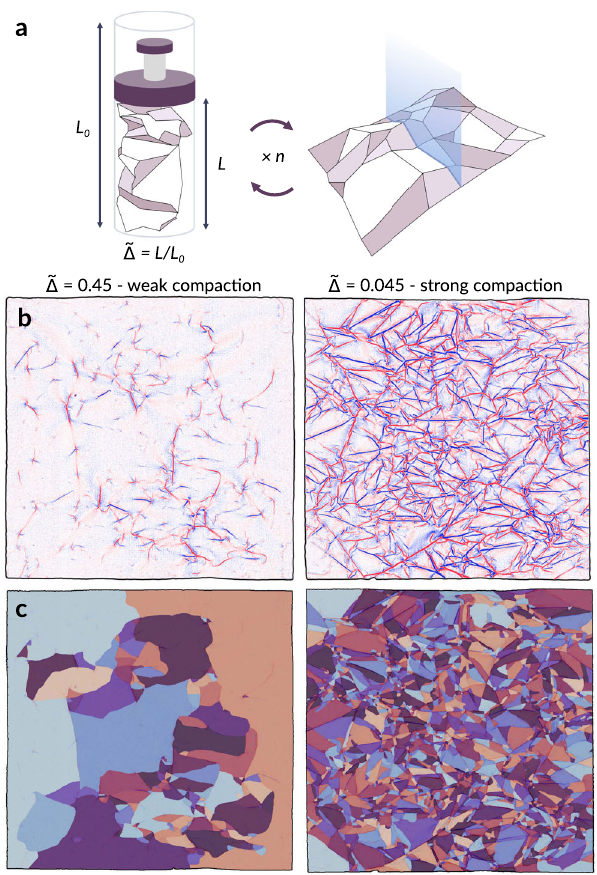
Fig. 1 Data processing. a An L 0 × L 0 Mylar sheet is uniaxially compressed to a compaction ratio ~ Δ ¼ L = L 0 , unfolded, and its height pro fi le scanned using a laser pro fi lometer, for n iterations. b The mean curvature obtained from the height pro fi les of two distinct sheets at different ~ Δ . Red and blue colors denote folds in opposite directions. c The facet segmentation of b , colored randomly to visually discern